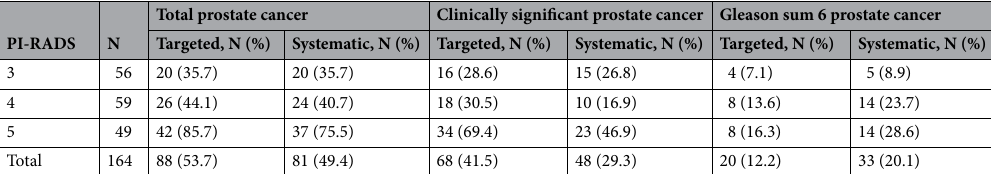
Table 2. Distribution of PI-RADS score detected by systematic biopsy and MRI-targeted biopsy. PI-RADS, Prostate Imaging–Reporting and Data System; MRI, Magnetic Resonance Imaging.